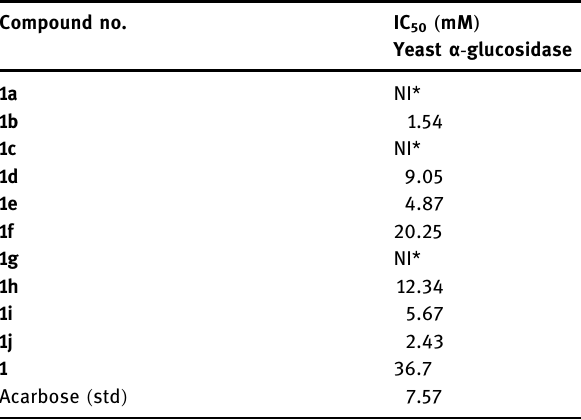
Table 1: Results of α - glucosidase inhibition assay of deriva